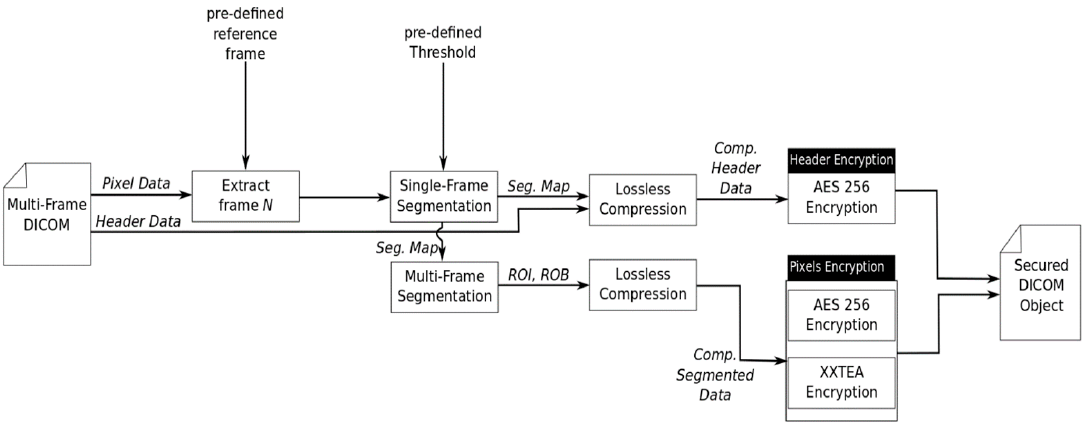
Figure 8. The proposed Frame-Based SE approach.